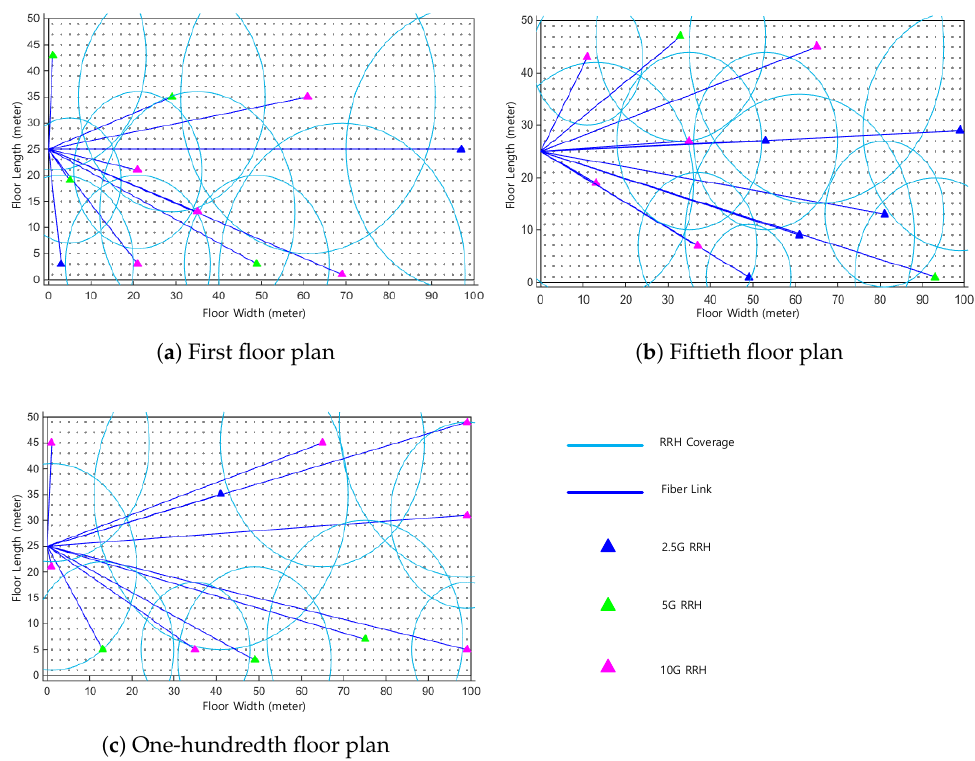
Figure 4. Illustrative example of the RRHs’ random distribution for the 100-story commercial building